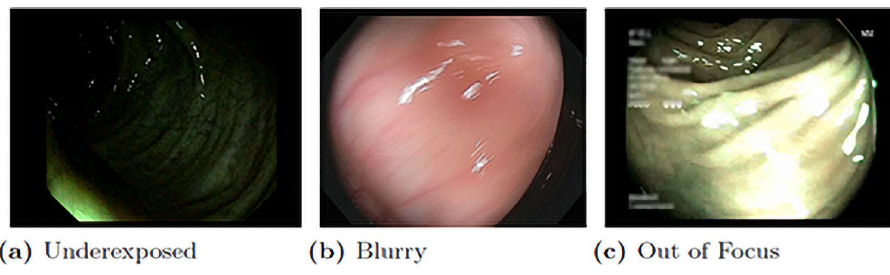
Fig 7. Some bad examples of colonoscopy